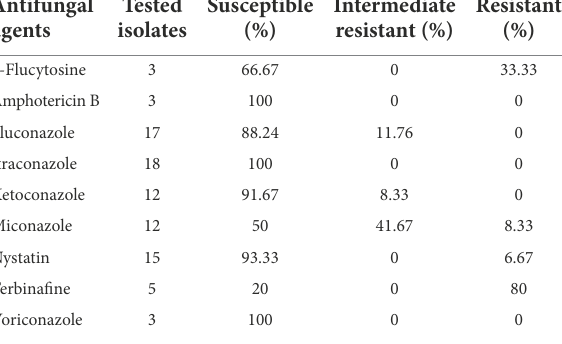
TABLE 4 Antifungal susceptibility profile of C. glabrata for all tested drugs in the past 10 years. Antifungal